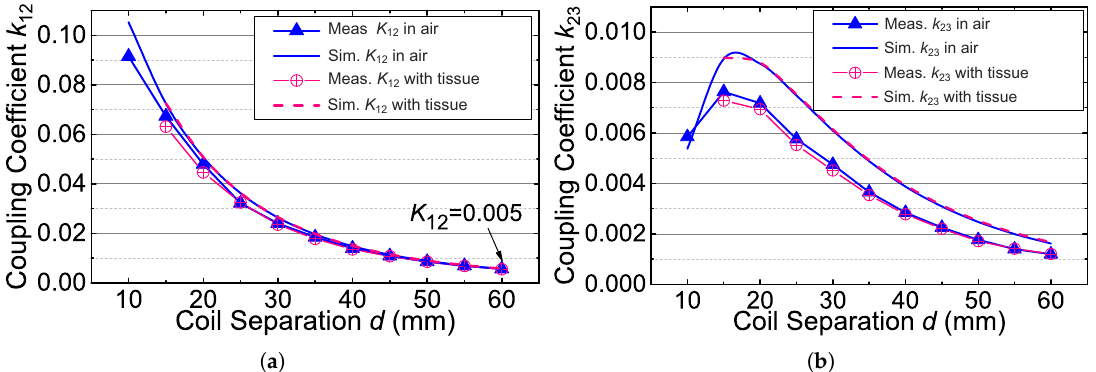
Figure 12. ( a ) Measured and simulated coupling coefficient k 12 versus the coil separation d in air and in tissue; ( b ) measured and simulated coupling coefficient k 23 versus the coil separation d in air and in tissue.